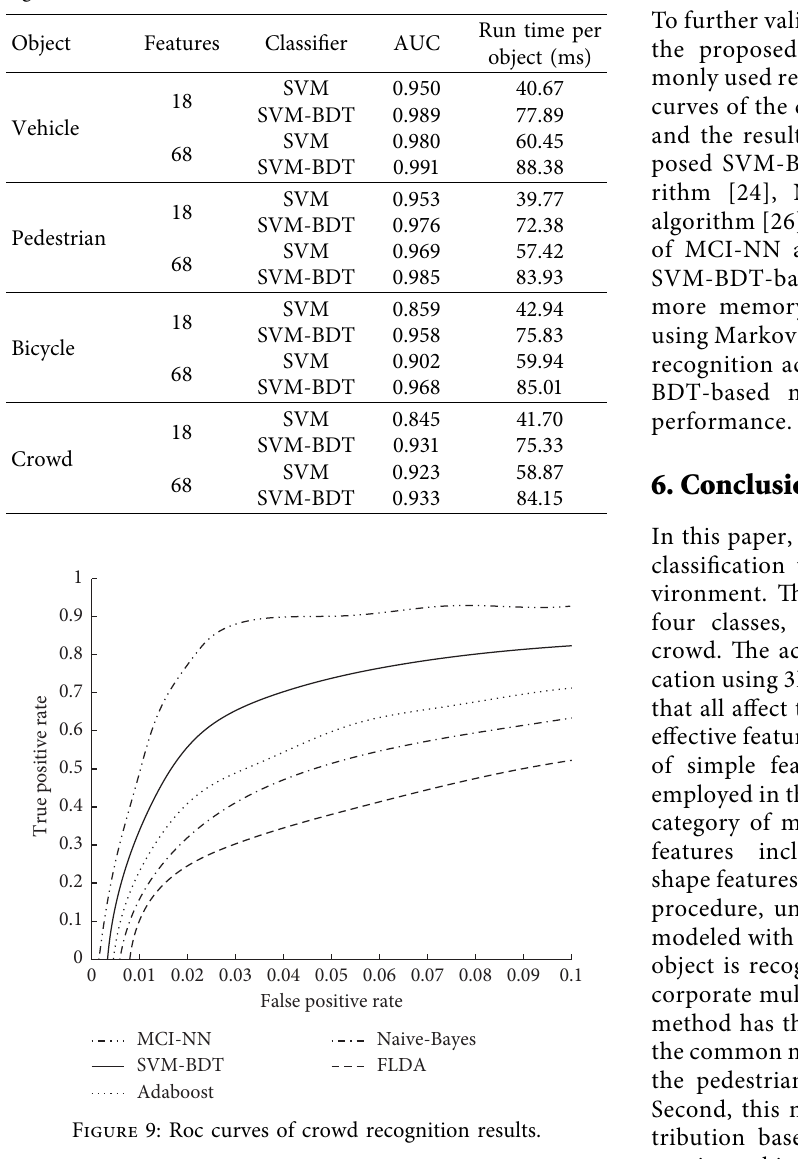
Table 4: Performance comparison of moving object classification algorithms.